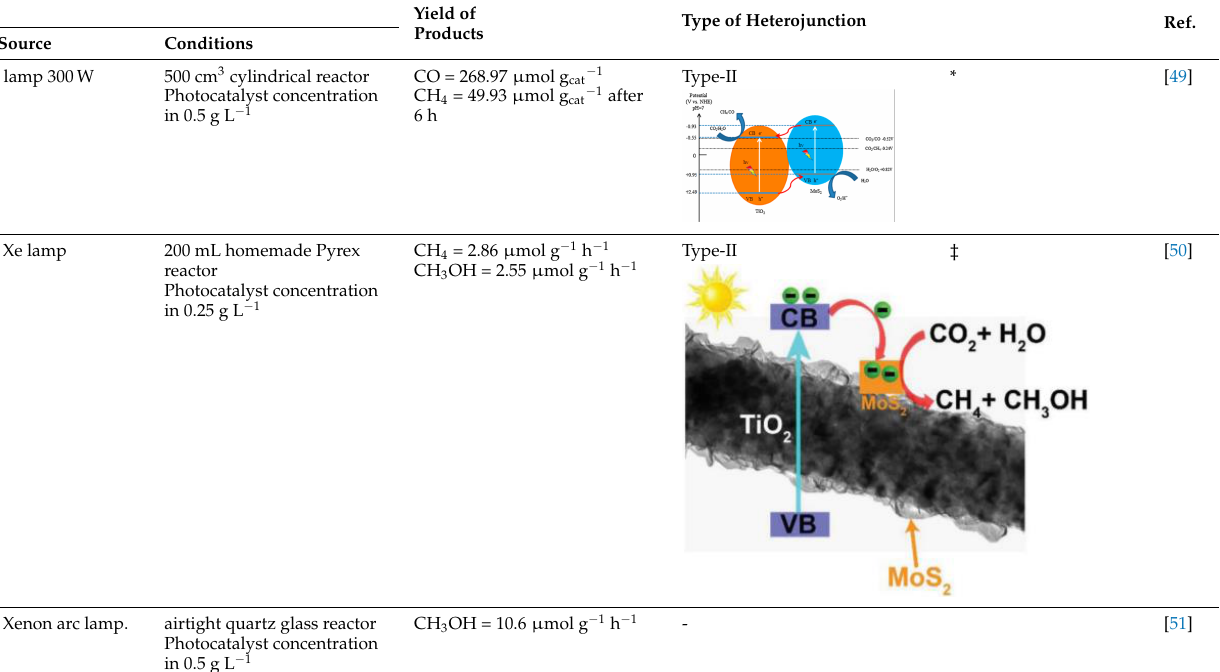
Table 6. CO 2 photoreduction using MoS 2 /TiO 2 heterojunction photocatalysts.